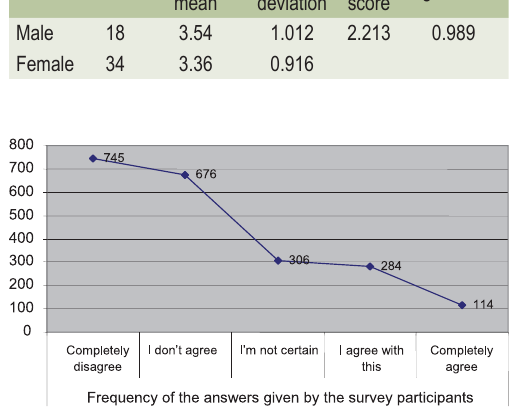
FIGURE 1. Occurrence frequency for different type of an- swers given by the participants in Clinical center at University of